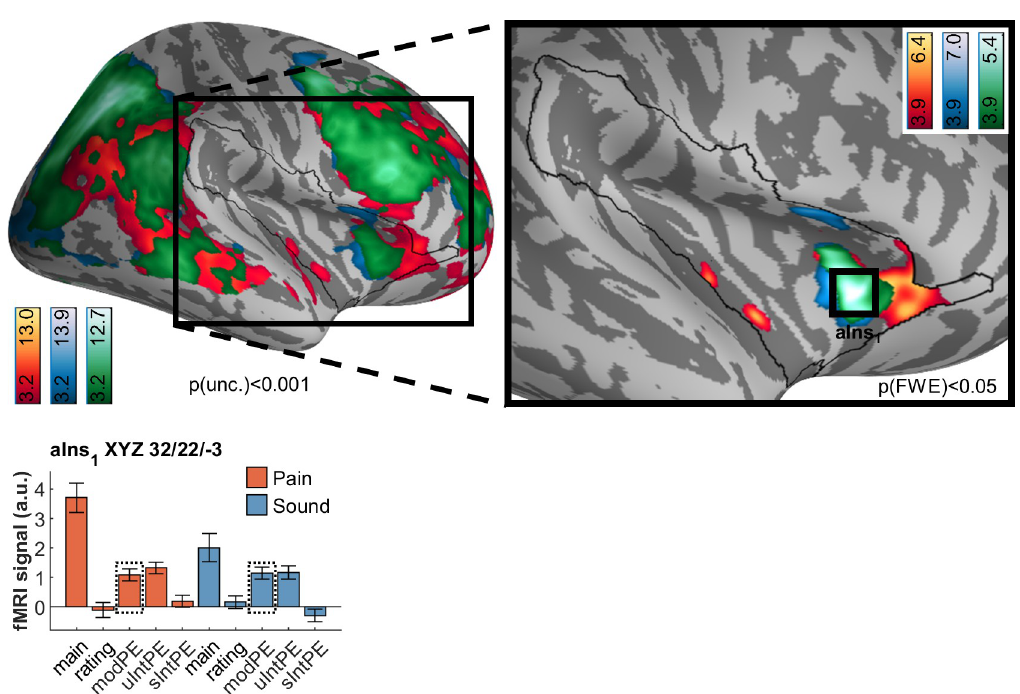
Fig 7. Brain activation following modality prediction errors in pain (red/yellow) and sound (blue) activation, including overlaps as per conjunction analyses (green). As with unsigned intensity PEs, peak activation following modality PEs in either modality is located in the anterior insula (aIns 1 ) and is largely subsumed in the common activation. Activations are overlaid on an average brain surface; for display purposes, activations in the whole brain lateral view are thresholded at p[uncorr.] < 0.001. The black line in the zoomed-in view delineates the region of interest and includes activations within the small volume FWE corrected at p[corr.] < 0.05. Peaks are shown for the small volume only. See Supporting information for peak positions in whole brain (S10 Fig) and brain volume slices (S11 Fig). In the fMRI signal bar graph, black rectangles highlight the regressors used for analysis; solid line indicates analysis with the respective individual regressor, and dashed line indicates conjunction analysis. fMRI signal labels refer to the regressors used for each modality: “main” for main effects of modality, “ratings” for behavioral ratings, “modPE” for modality PEs, “uIntPE” for unsigned intensity PEs, and “sIntPE” for signed intensity PEs. Data used to produce the figure can be found at https://www.doi.org/10.17605/OSF.IO/7JBV3. fMRI, functional magnetic resonance imaging; FWE, family-wise error; PE, prediction